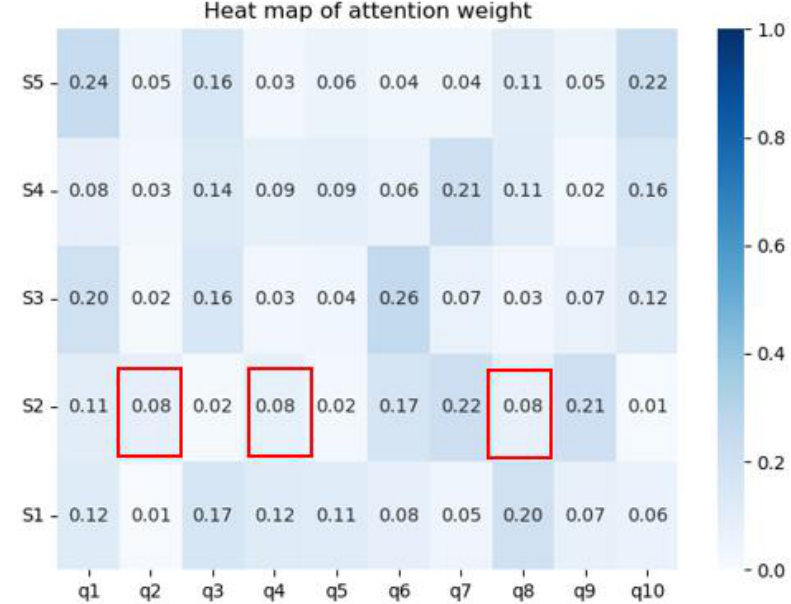
Figure 6. Initial attention weights.